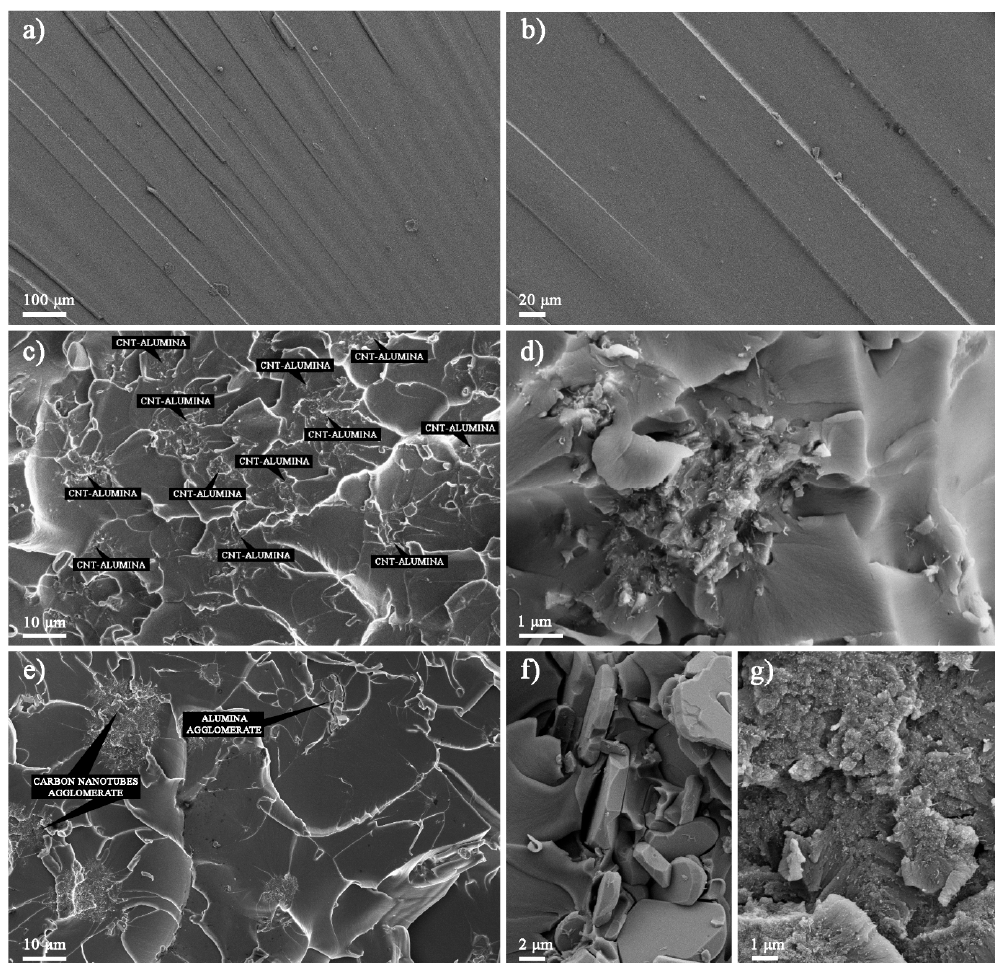
Figure 5. FESEM images of the neat epoxy at magnification of ( a ) 100×; ( b ) 300×; Epoxy/HYB at magnification of ( c ) 1000×; ( d ) 10,000×, and Epoxy/MIX at magnification of ( e ) 1000×; ( f ) 3000×; and ( g ) 5000×.